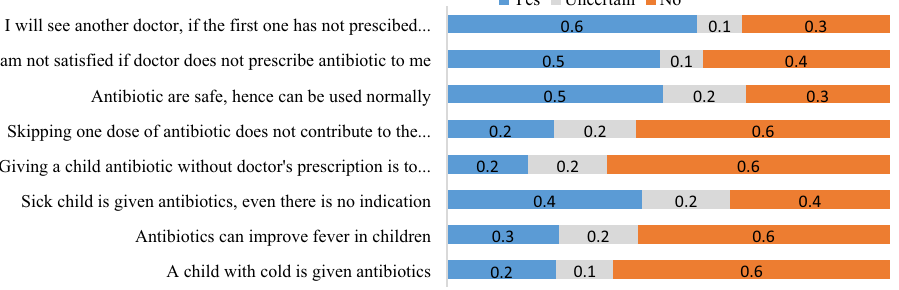
Figure 2. Parents’ attitude toward rational use of antibiotics among children. Among 2772 parents assessed for their attitude towards appropriate antibiotic use in children, 56.0% had a negative attitude to non-antibiotics prescriptions and were ready to seek another doctor who would prescribe an antibiotic for their children. The majority (63.8%) were ready to give their children antibiotics without a doctor’s prescription. Additionally, 44.1% could provide antibiotics for their children, even without an indication.